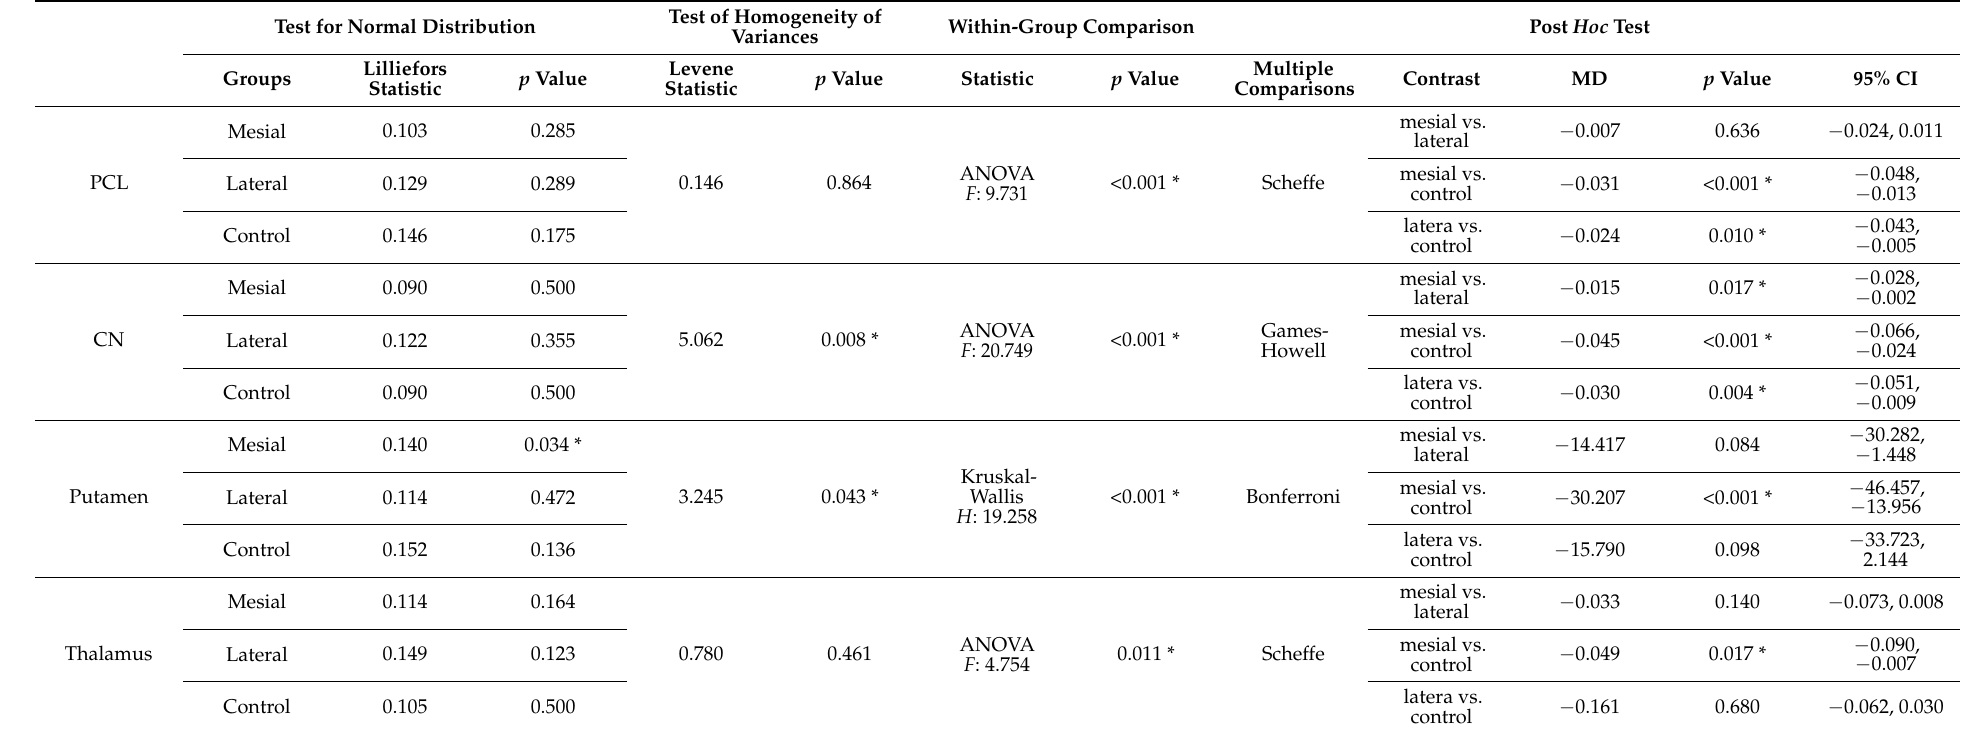
Table 2. Statistical analysis in ROI-based metabolic comparison among different